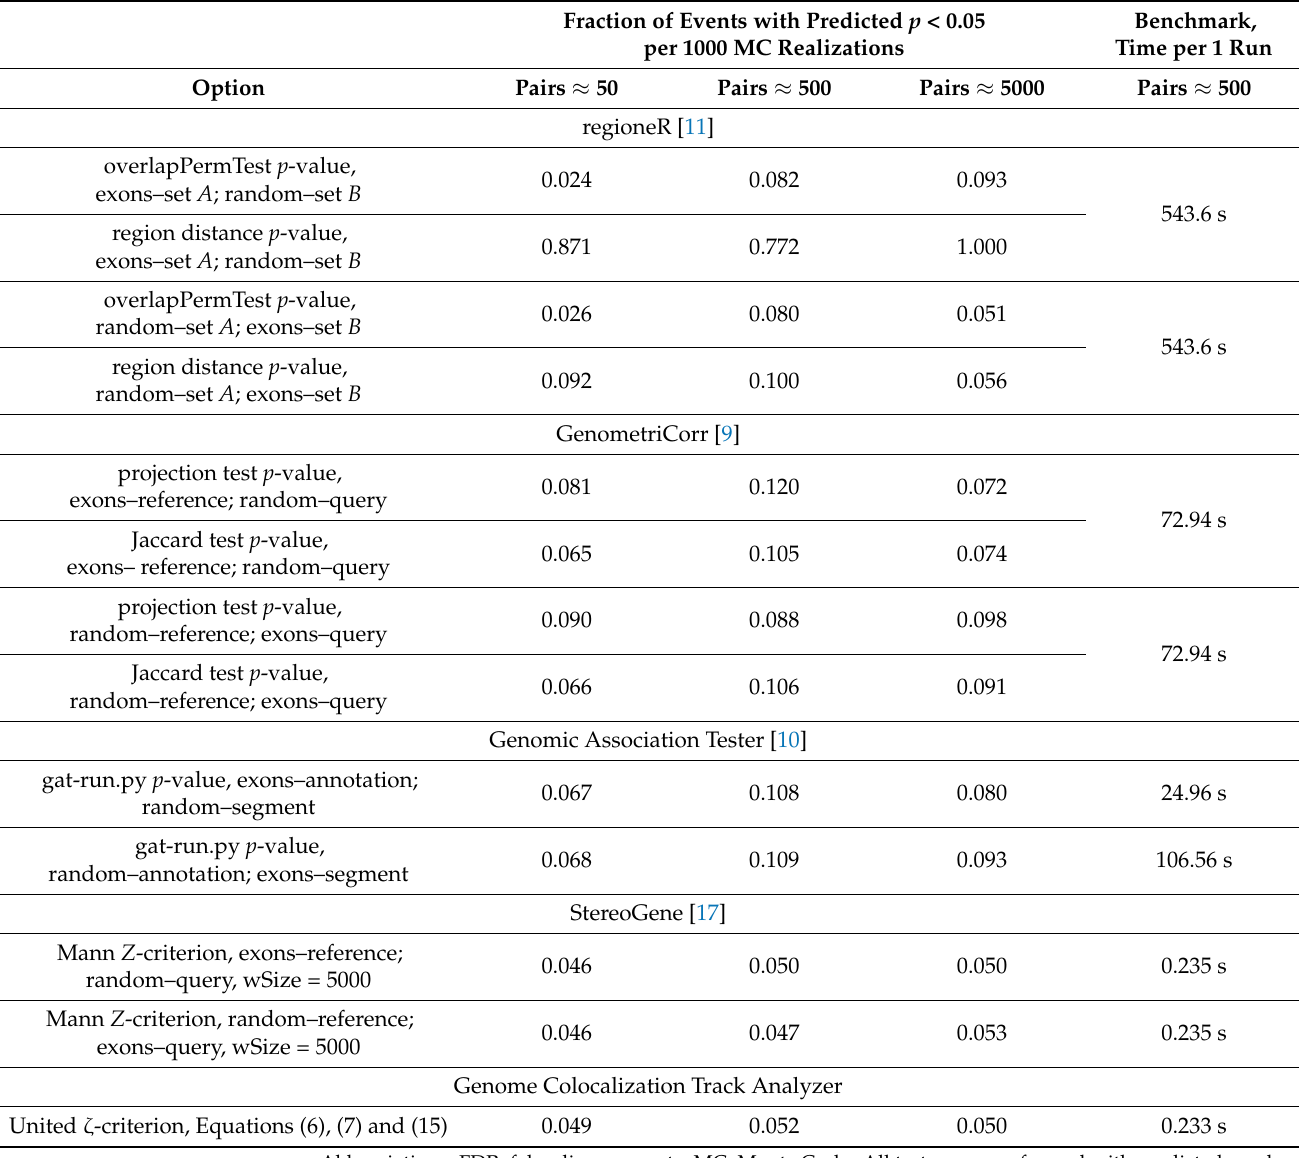
Table 1. FDR for the tests on the absence of correlations between exons on the forward strand of human chromosome 1 and random